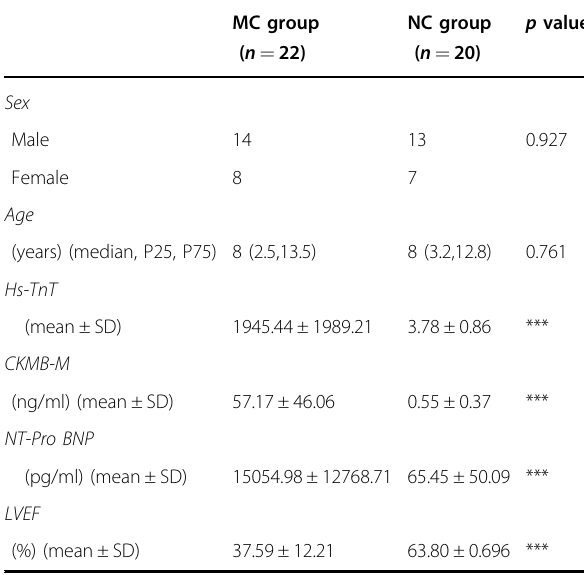
Table 1 Clinical characteristics of myocarditis (MC) and normal control (NC)